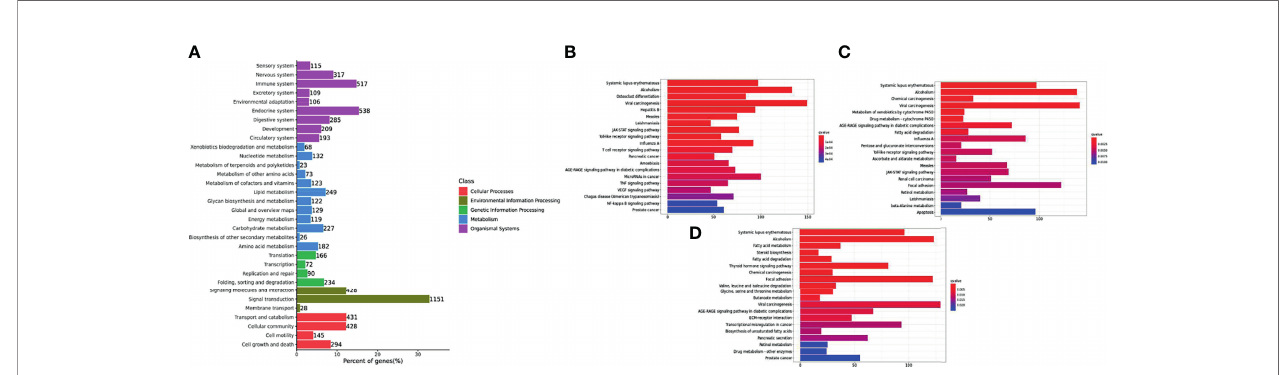
FIGURE 5 | Histogram of the top 20 most-enriched KEGG pathways of DEGs in channel cat fi sh infected by bacteria. The Y-axis represents KEGG pathway categories. The X-axis represents the statistical signi fi cance of enrichment. (A) represents the classi fi cation of total KEGG, (B) represents the top 20 KEGG enriched metabolic pathways in the C1_T6 group, (C) represents the top 20 KEGG enriched metabolic pathways in the C1_T12 group and (D) represents the top 20 KEGG enriched metabolic pathways in the